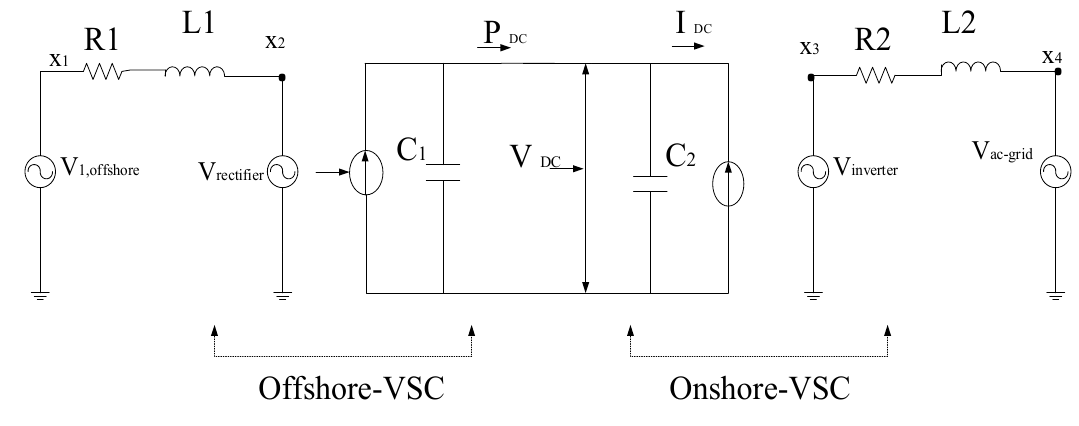
Figure 13. Single line representation of VSC-HVD circuit.